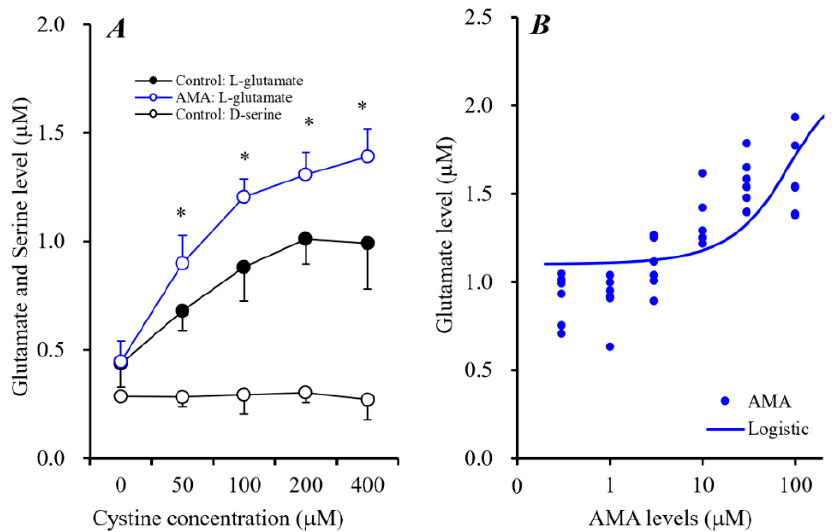
Figure 5. Concentration-dependent effects of L-cystine (0~400 μ M) on astroglial release of L-glutamate and D-serine and effects of AMA (10 μ M) on L-cystine-dependent L-glutamate release ( A ). Ordinate indicates mean ± SD ( n = 6) of extracellular levels of L-glutamate or D-serine ( μ M); abscissa: concentration of L-cystine. * p < 0.05 relative to the control by two-way analysis of variance with Tukey’s post hoc test. Concentration-dependent effects of AMA (0–100 μ M) on 100 μ M L-cystine-induced astroglial L-glutamate release ( B ). Ordinate indicates mean ± SD ( n = 6) of extracellular levels of L-glutamate ( μ M); abscissa: concentration of AMA (logistic regression analysis).